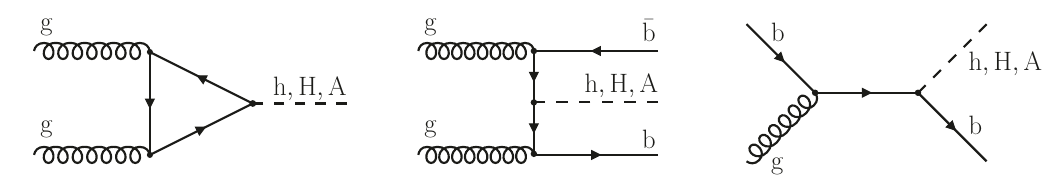
Figure 1 . Diagrams for the production of neutral Higgs bosons (left) via gluon fusion and (middle and right) in association with b quarks. In supersymmetric extensions of the SM, the super-partners also contribute to the fermion loop, shown in the left panel. In the middle panel a pair of b quarks is produced from two gluons (the LO process in the four-(cid:13)avor scheme). In the right panel the Higgs boson is radiated from a b quark in the proton (the LO process in the (cid:12)ve-(cid:13)avor